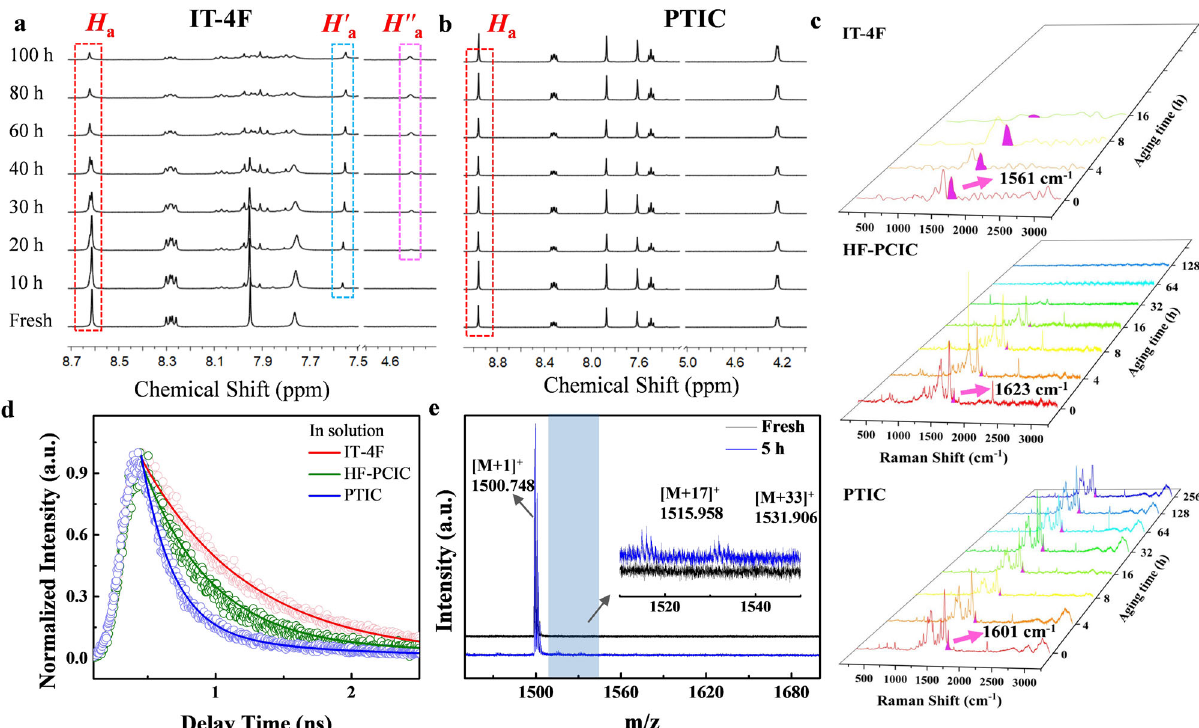
Fig. 3 Structural characterizations of photo-illuminated NFAs. 1 H NMR of a , IT-4F and b , PTIC in solution under continuous one-sun-equivalent illumination. Line 1 – 8 represents the signals at different times (fresh, 10 h, 20 h, 30 h, 40 h, 60 h, 80 h, 100 h). c Raman spectra of IT-4F, HF-PCIC, and PTIC under continuous one-sun-equivalent illumination. The highlighted purple peaks represent the signals of the vinyl bond. d Time-resolved photoluminescence for IT-4F, HF-PCIC, and PTIC in solution. e MALDI-TOF of IT-4F fi lm before and after illumination in